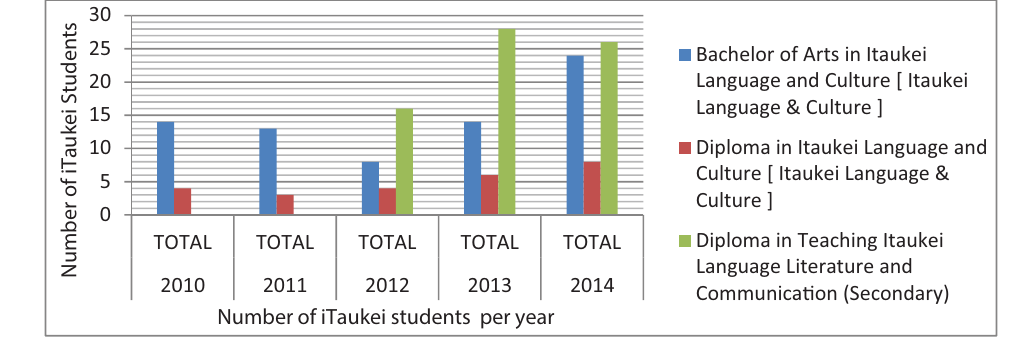
(Colour online) Student enrolments as per the different